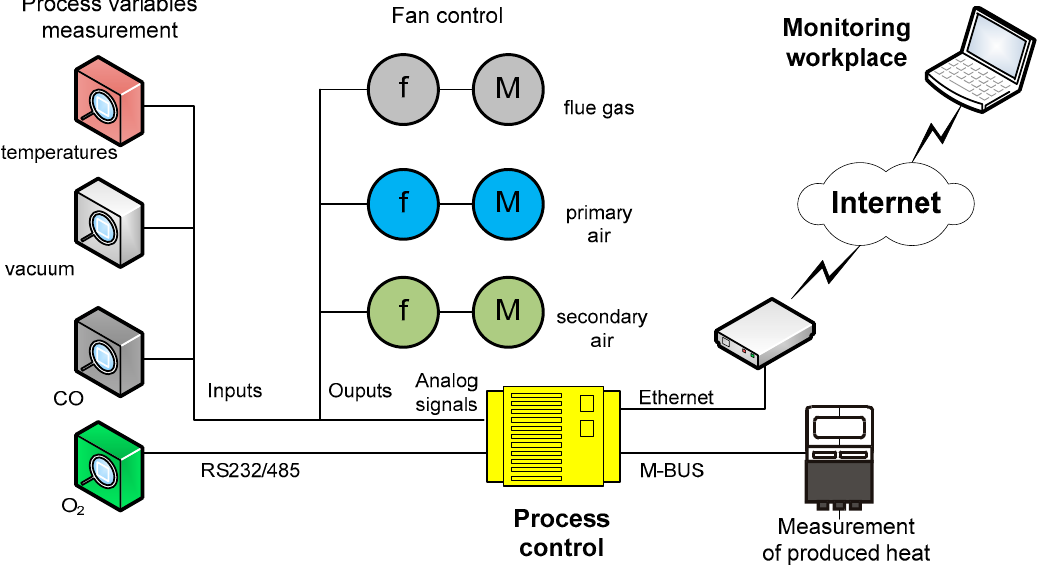
Figure 4. A structure of the automatic control and remote monitoring system.